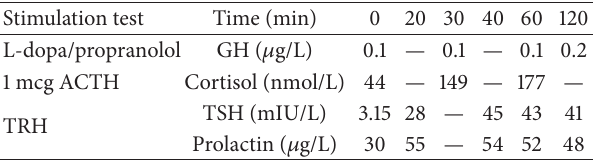
Table 1: Results of functional endocrine testing in Case